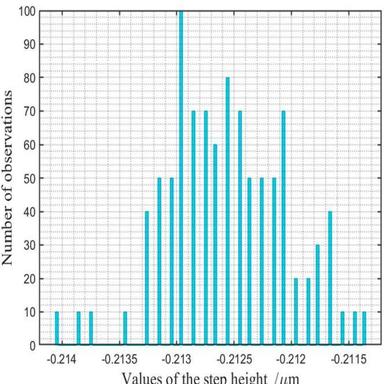
The distribution the heights of subtracting the datum plane from the plane SB in Experiment 3.